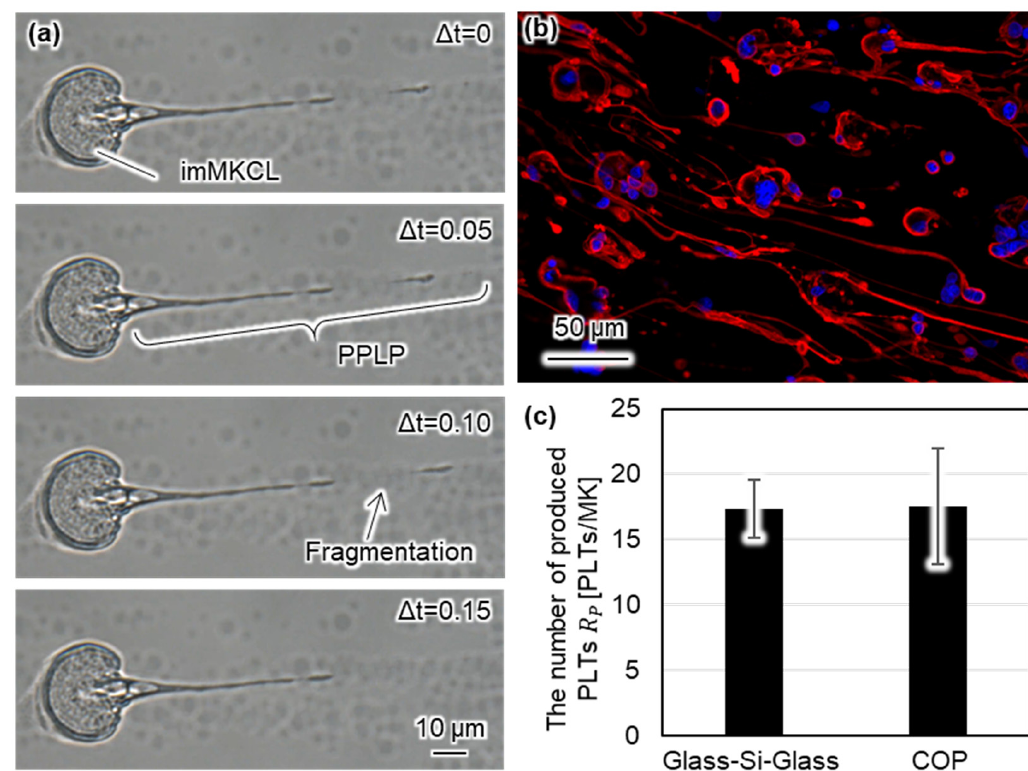
Figure 5. Experimental results of PLP production. ( a ) Bright-field image of PLP production, ( b ) Fluorescence image of PLP production, and ( c ) Evaluation of the number of produced PLPs.